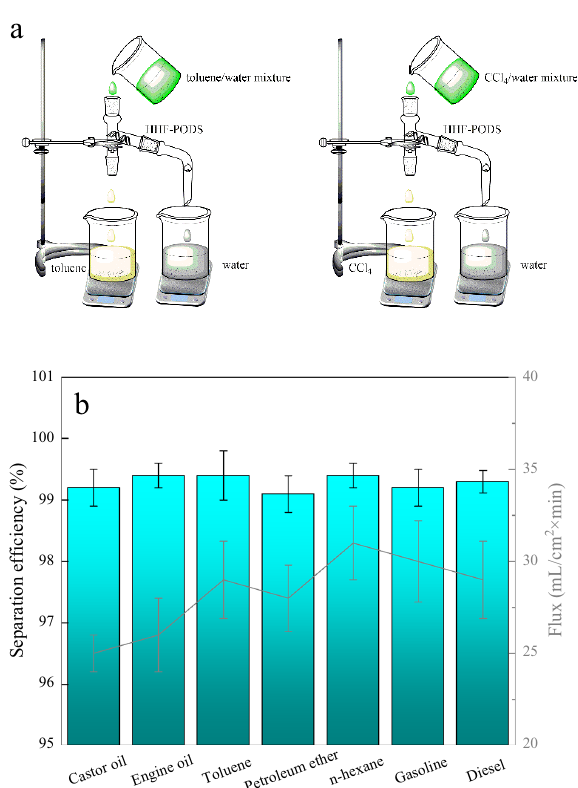
Figure 5. ( a ) Schematic diagram of the homemade oil/water mixture separation system. ( b ) The separation efficiency and flux of HHF-PODS for different organic solvents/water mixtures.